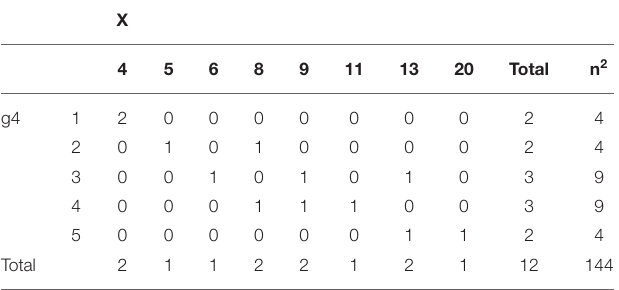
TABLE 4 | Crosstable of variables g 4 and X.